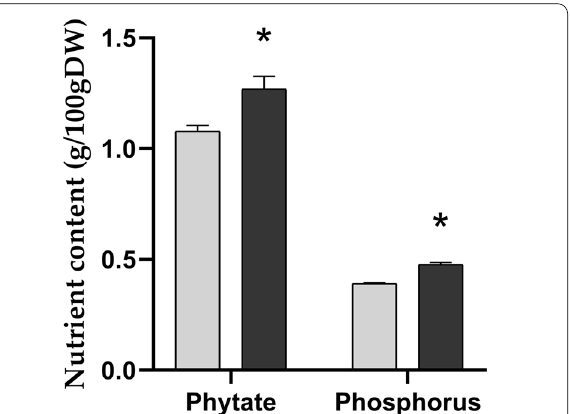
Fig. 9 Total phytate comparison by Harland and Oberleas method and total phosphorus comparison by ICP‑OES (* P < 0.05;